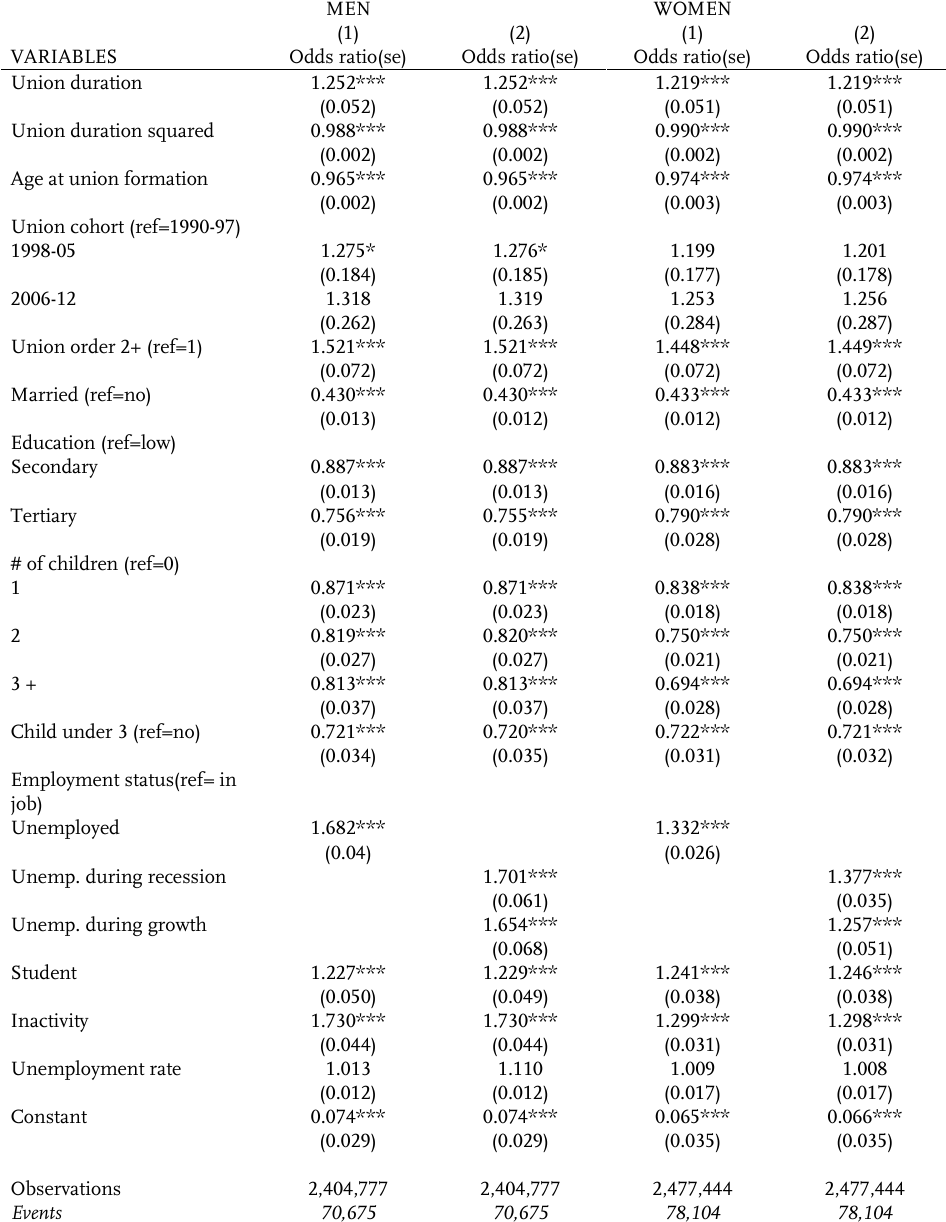
Table A.2 : Discrete time model, full results by country: Finland